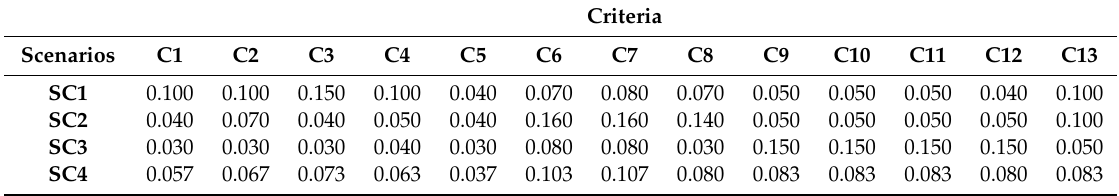
Table 2. Criteria weights each stakeholder scenario (SC1-3) and a compromised scenario (SC4).